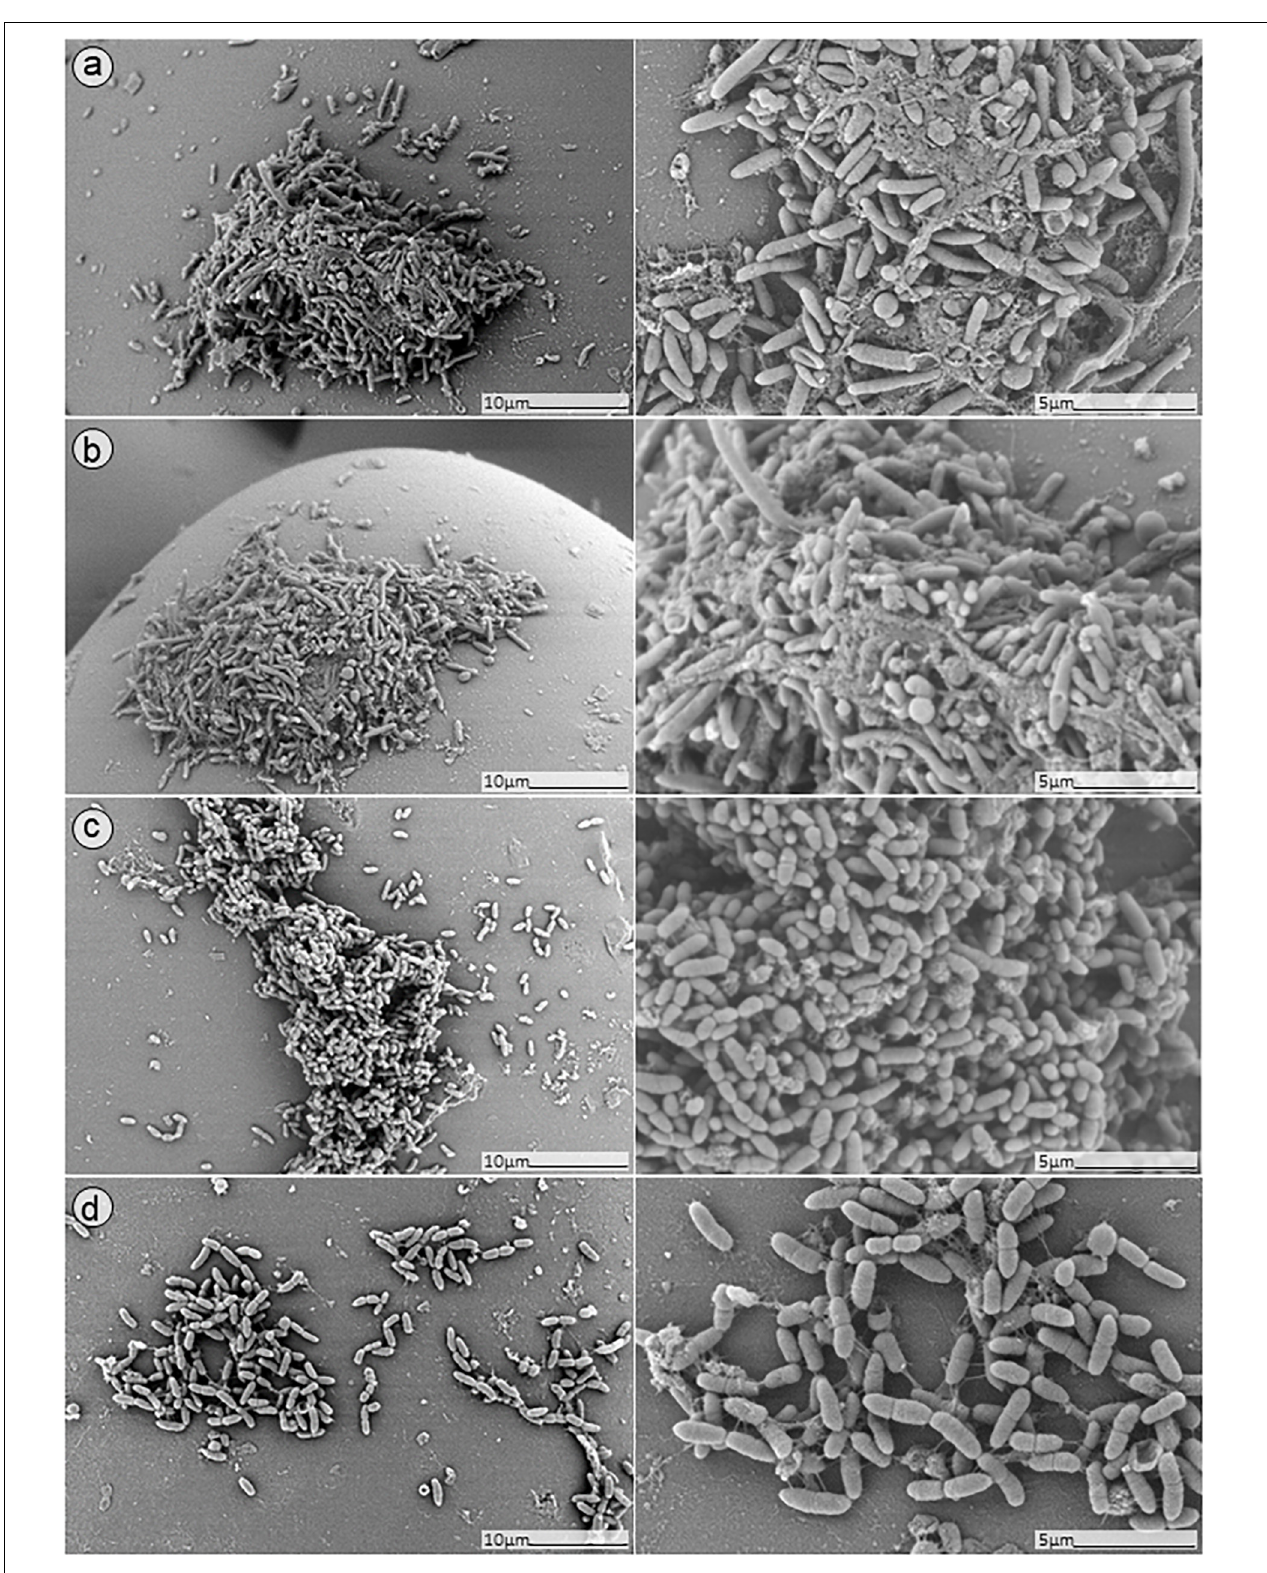
FIGURE 8 | SEM analysis of S. aureus/P. aeruginosa dual-species biofilms grown on porous glass beads for 24 h without treatment (a) and after exposure to 24 h monotherapy with (b) ciprofloxacin (1 mg/L); (c) PYO; or (d) pyo+sb-1.